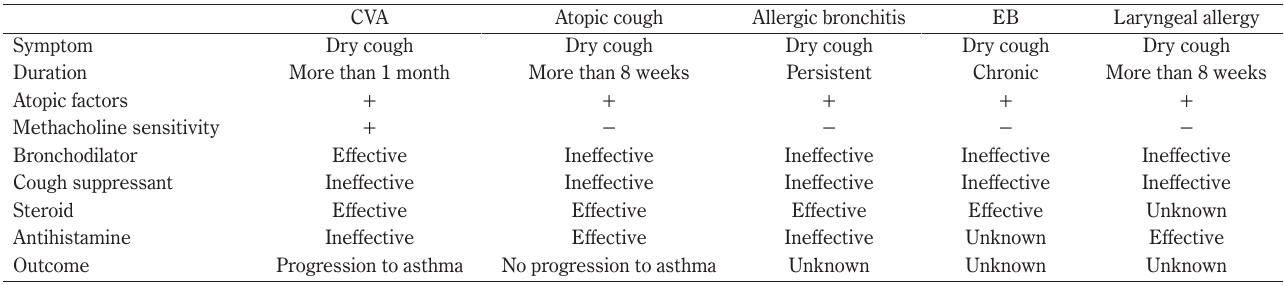
Table 5 Clinical features of the differential diagnoses for laryngeal allergy (modified from reference